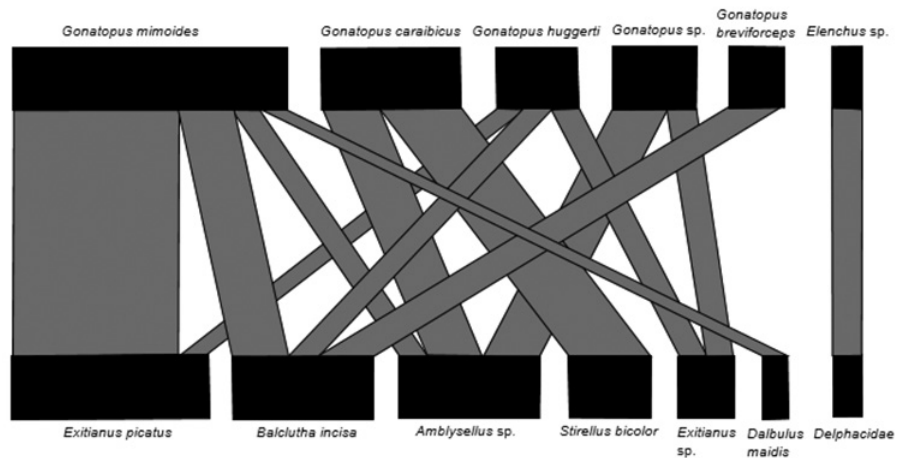
Figure 2. Quantitative food web of parasitoid-host interaction found on the edges of maize agroecosys- tem in the winter seasons of 2014 and 2015. Top names are the parasitoid species and bottom names are the host